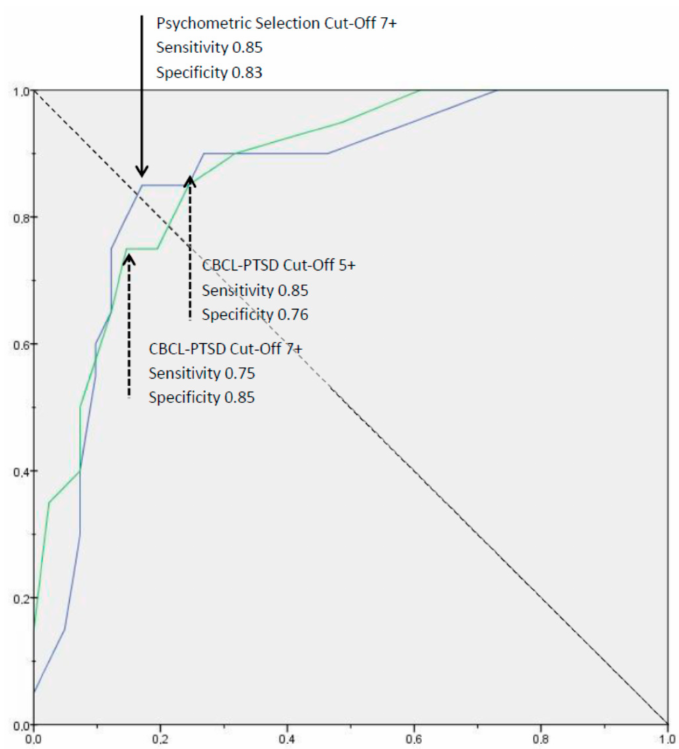
Figure 1. Receiver Operating Characteristic (ROC) Curve. The green line depicts the ROC curve of the PTSD-CBCL subscale (area under the curve (AUC) = 0.88), the blue line denotes the ROC curve of the psychometrically guided item selection (AUC = 0.86). “Cut-Off 7+”—at least 7 symptoms are